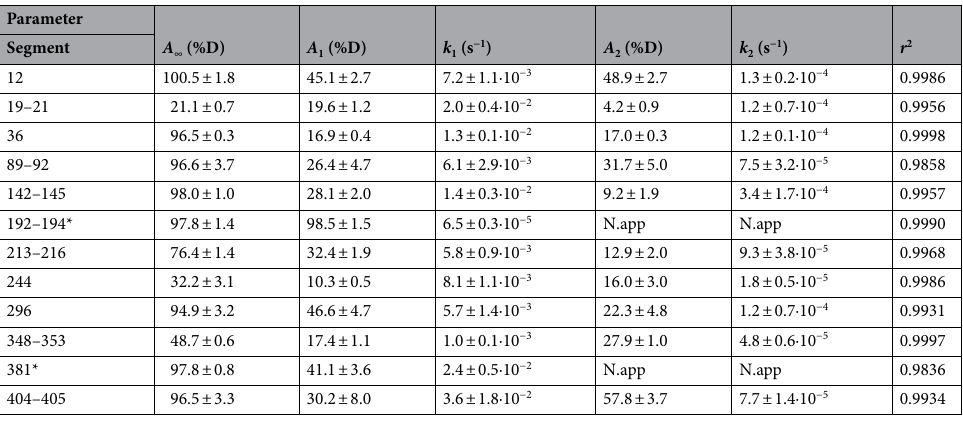
Table 5. Best-fit parameters for selected segments of WT hPGK1 determined by HDXMS. Good fittings were obtained using a two-exponential function ( A ∞ is the total amplitude of %D uptaken at t = ∞, A 1 and k 1 are the amplitude and rate constant for the fast phase, while A 2 and k 2 are those for the slow phase). *The fitting to a double-exponential function did not converge. The values reported corresponded to a fitting using a one- exponential function with a burst-phase. N. app.- not